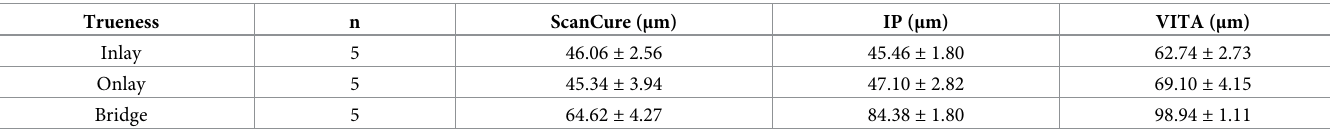
Table 1. The RMS values of three experimental groups (ScanCure, IP, VITA) in each reference model (mean ± SD). Trueness